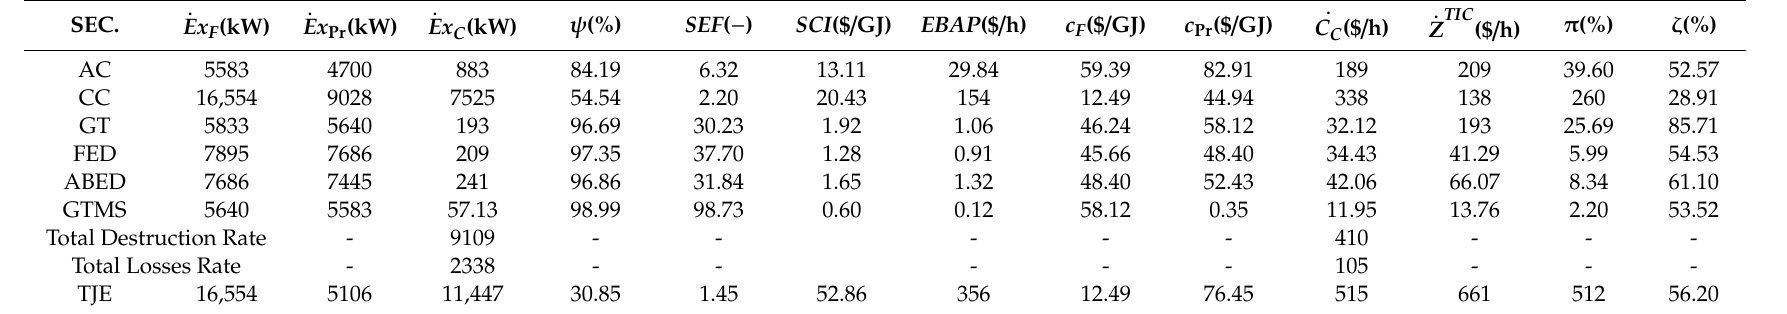
Table 10. Results for exergy, exergoeconomic and sustainability performance indicators for MIL PM with kerosene fuel use.